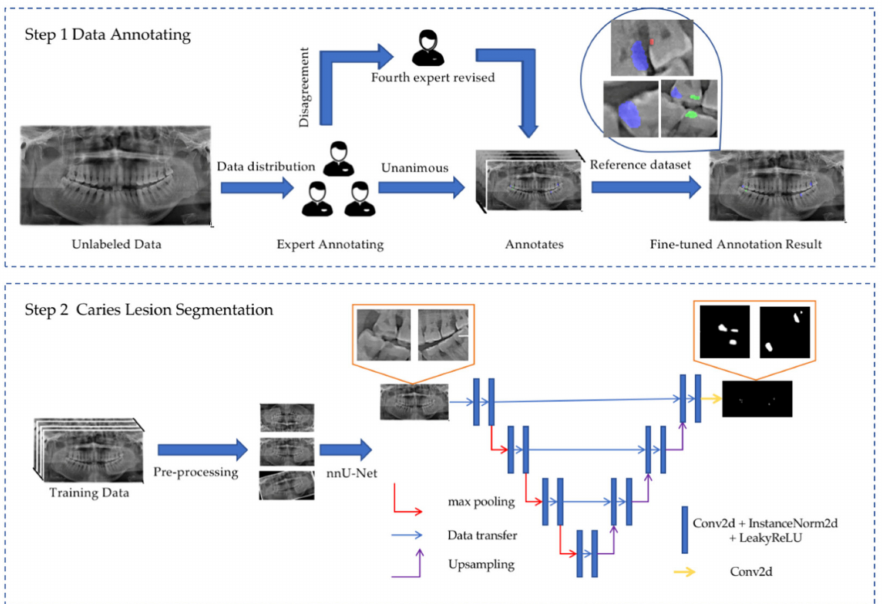
Figure 1. Details of nnU-Net architecture and implementation details in caries segmentation. In step 1, three dental experts were trained to implement dental caries labels and annotations, and a fourth expert revised any controversial results. Purple circle indicates D3 lesions, green circle indicates D2 lesions and red circle indicates D1 lesions. Step 2 shows nnU-Net and how it works in caries lesion segmentation.